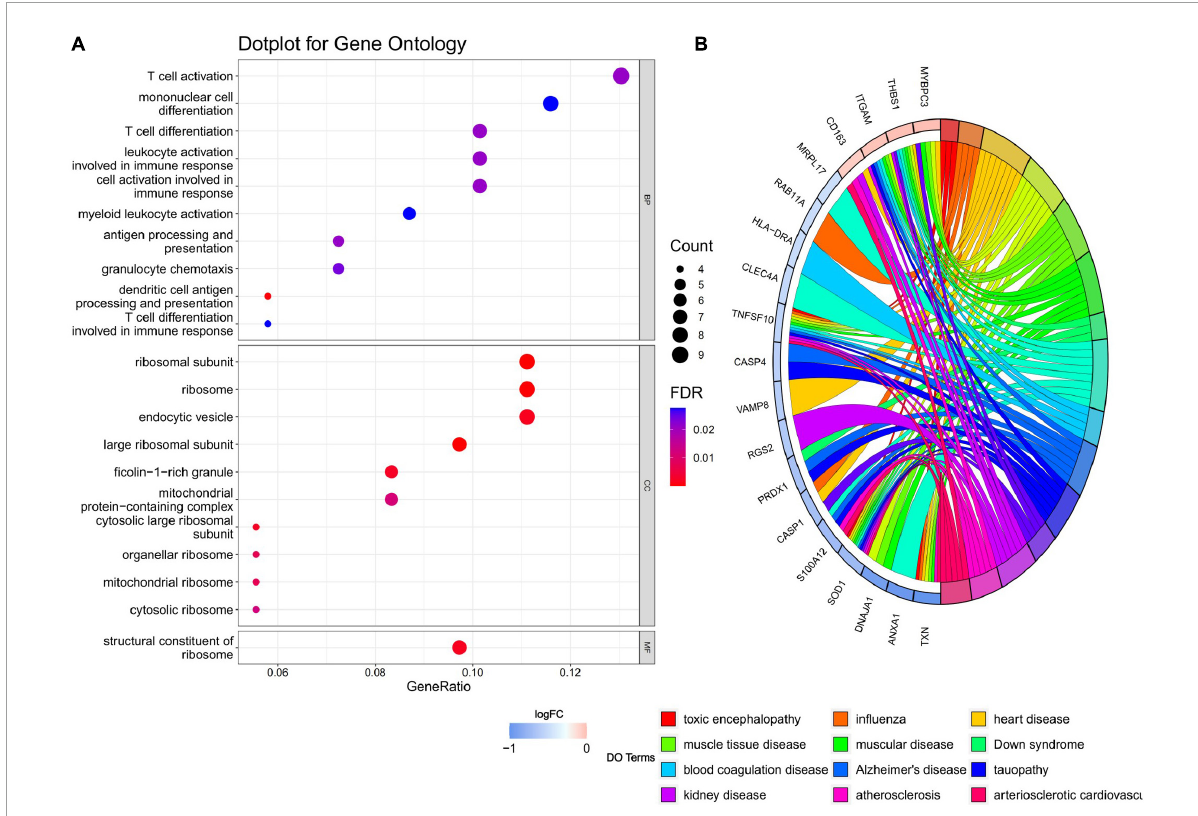
FIGURE3 (A) GO enrichment analysis, where the horizontal axis represents the proportion of DEGs under the GO term. Top 10 pathways with most significant P -value were shown and ordered by gene ratio. BP, biological process; CC, cellular component; MF, molecular function. (B) DO enrichment analysis. Chord diagram showed the correlation between diseases and common DEGs, with different colors corresponding to different DO terms.